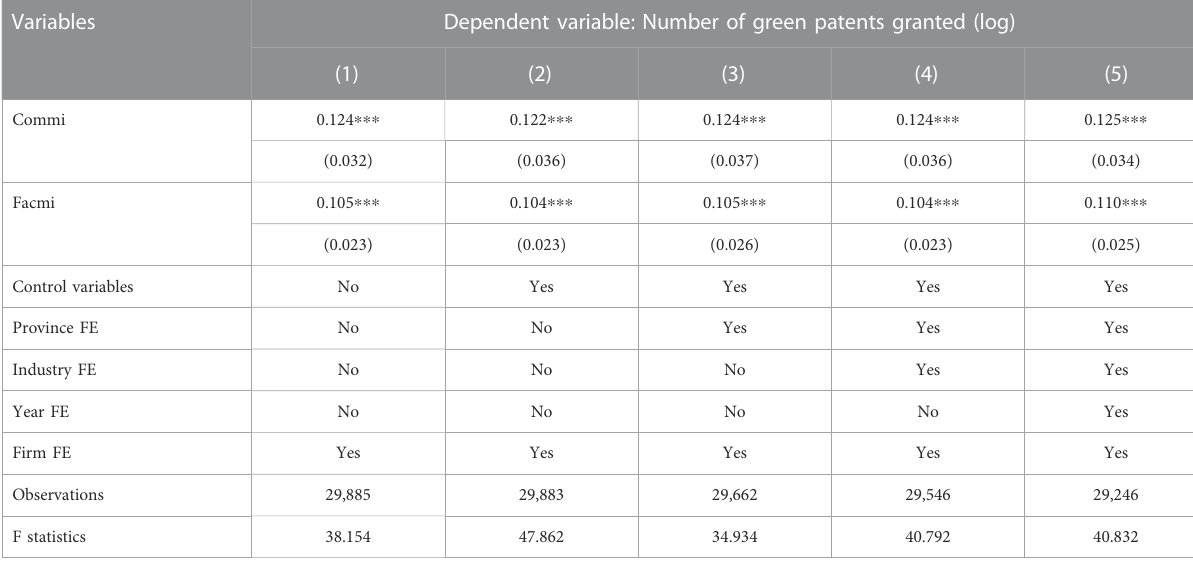
TABLE 4 2SLS estimates of the impact of market integration on green technology